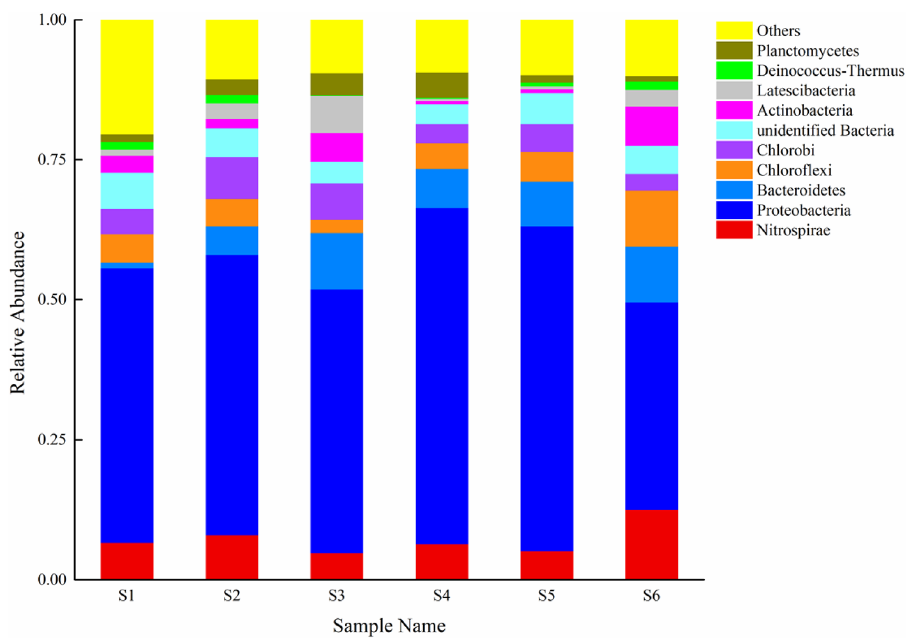
Figure 6. Taxonomic classification (phylum level) of the bacterial communities in each sludge sample